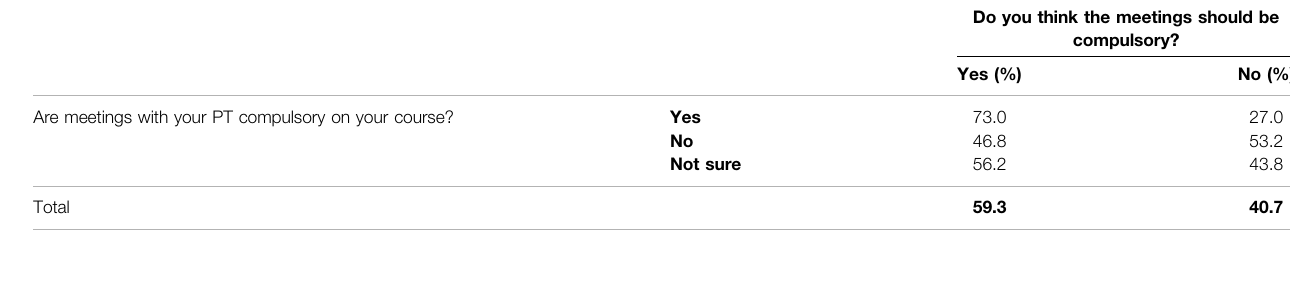
TABLE 3 | Cross-analysis of questions regarding assessments linked to the Personal Tutoring Scheme (PTS). Are any of your assessments marked by your